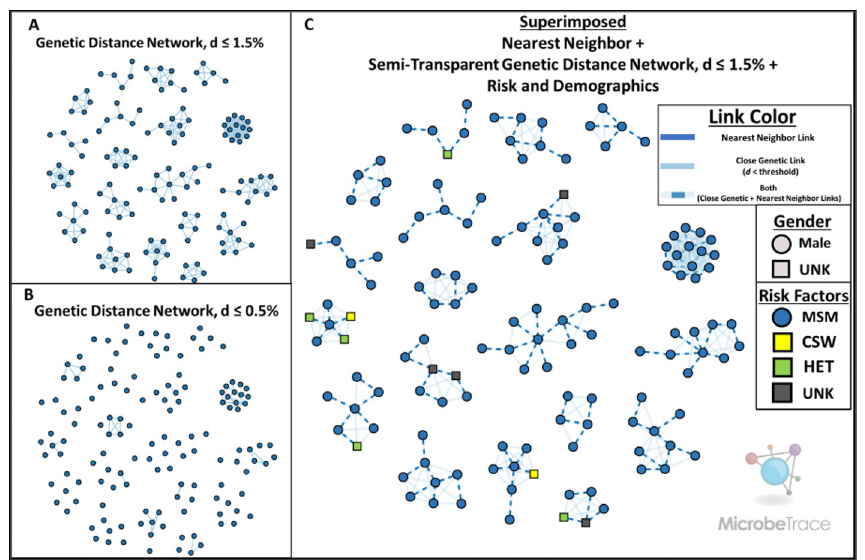
Fig 2. MicrobeTrace excels at rendering pathogen genetic distance networks and mapping visual characteristics to user-provided metadata. ( 2A ) The HIV-1 partial polymerase (pol) distance network, with a genetic distance threshold (d) of 1.5%. ( 2B ) The same HIV-1 pol network shown in 3A with node positions held constant, but with a more stringent genetic distance threshold (d) of 0.5%. ( 2C ) The same HIV-1 pol network shown in 3A with node positions held constant. Nearest connected neighbor links have been superimposed as dashed lines. The transparency of links that do not connect nearest neighbors has been increased. Gender and transmission risk factors have been mapped to node shape and color,